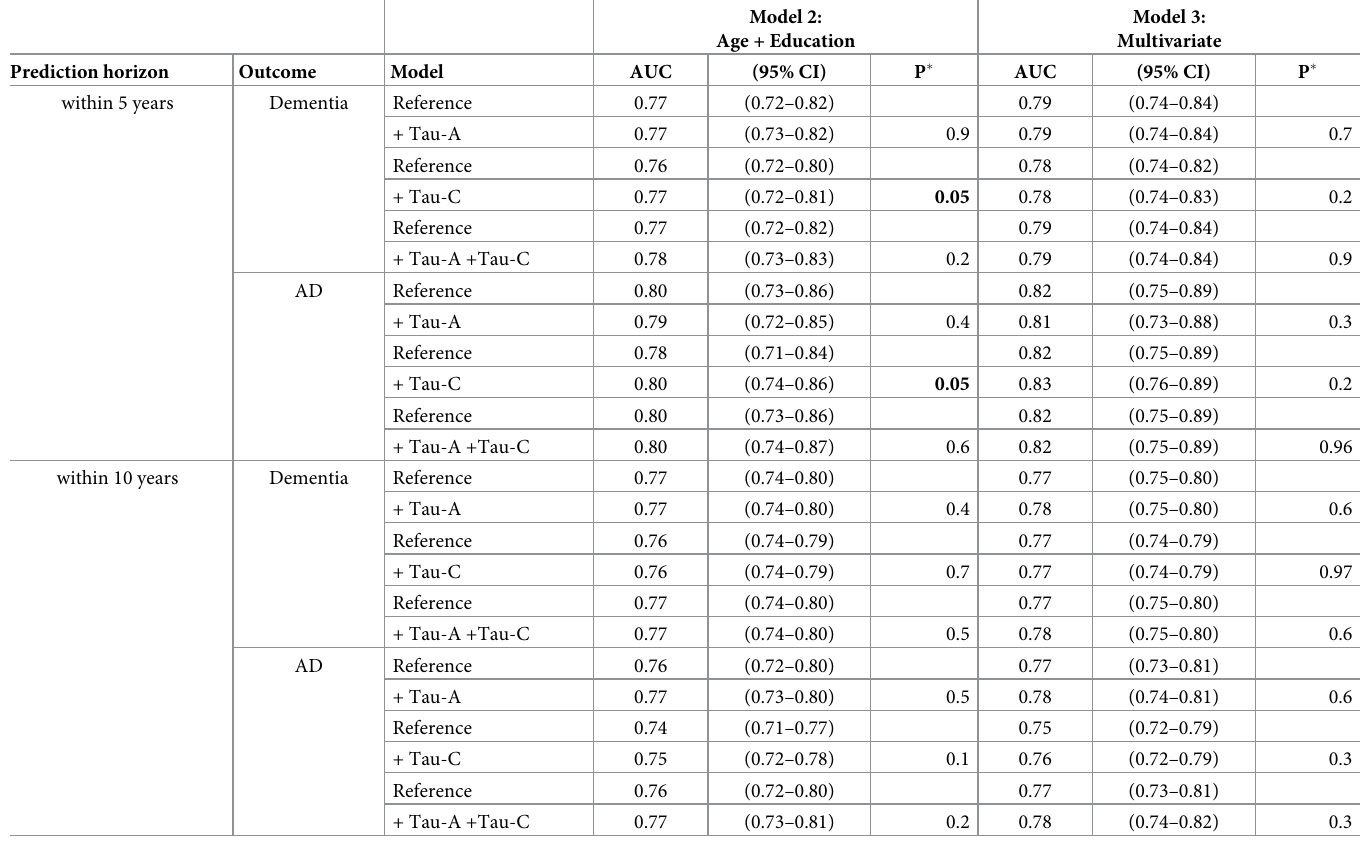
Table 3. Improvement in risk prediction with the addition of Tau-A, Tau-C or Tau-A and